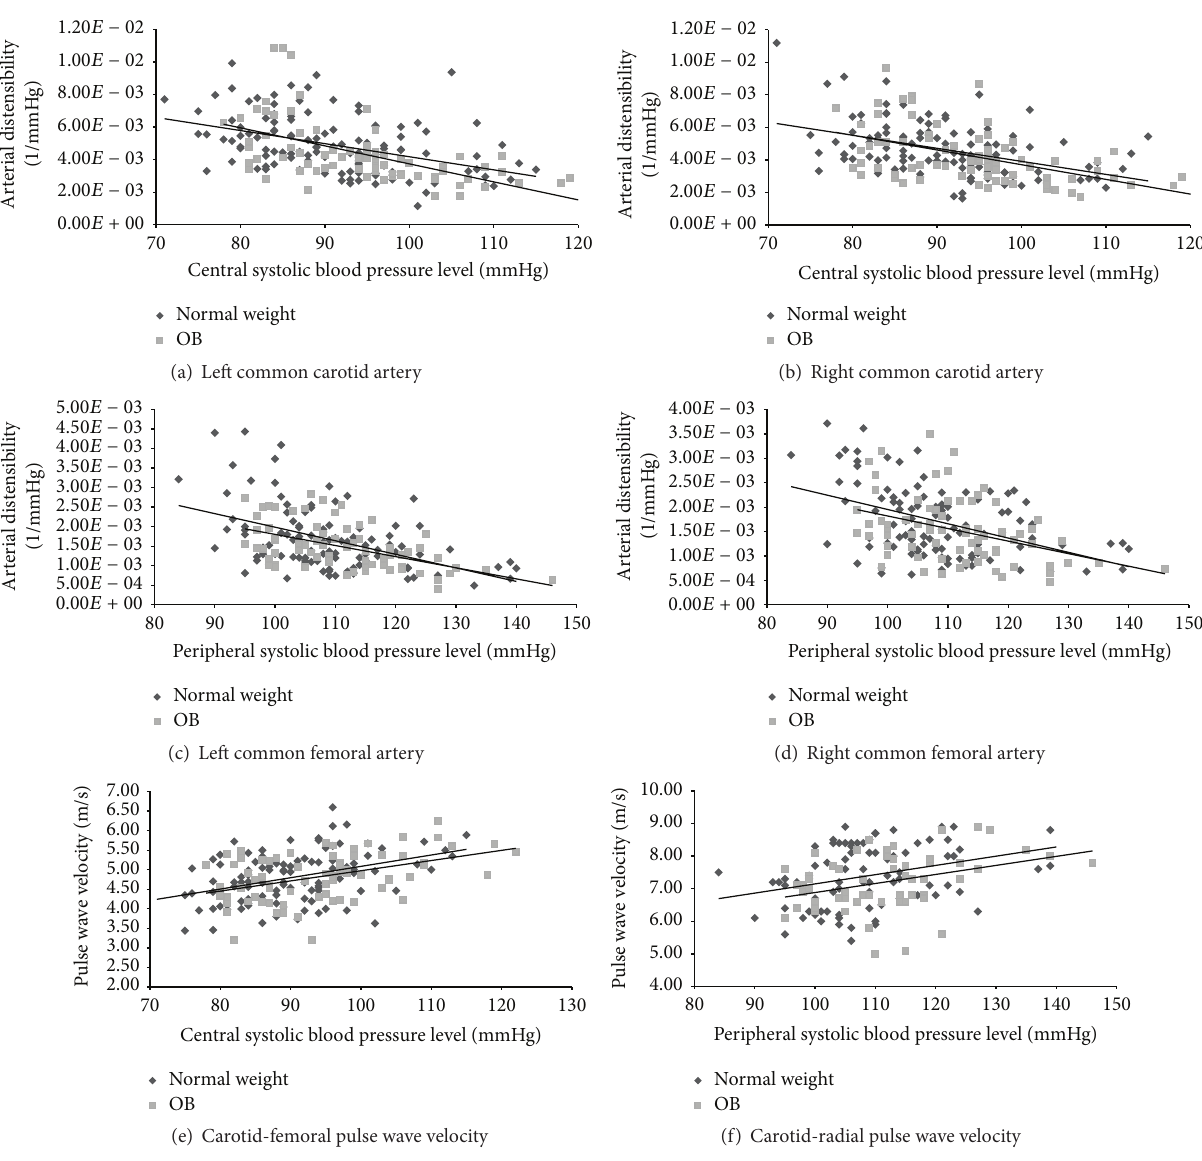
Figure 3: Correlation analysis (linear regression plots) between stiffness parameters and blood pressure levels for normal weight (NW) and obese (OB) children and adolescents. Nonstatistical differences were found when equations (for the same artery) were compared (slopes comparisons) between NW and OB groups (data shown in Table 3), indicating a similar arterial stiffness-blood pressure association